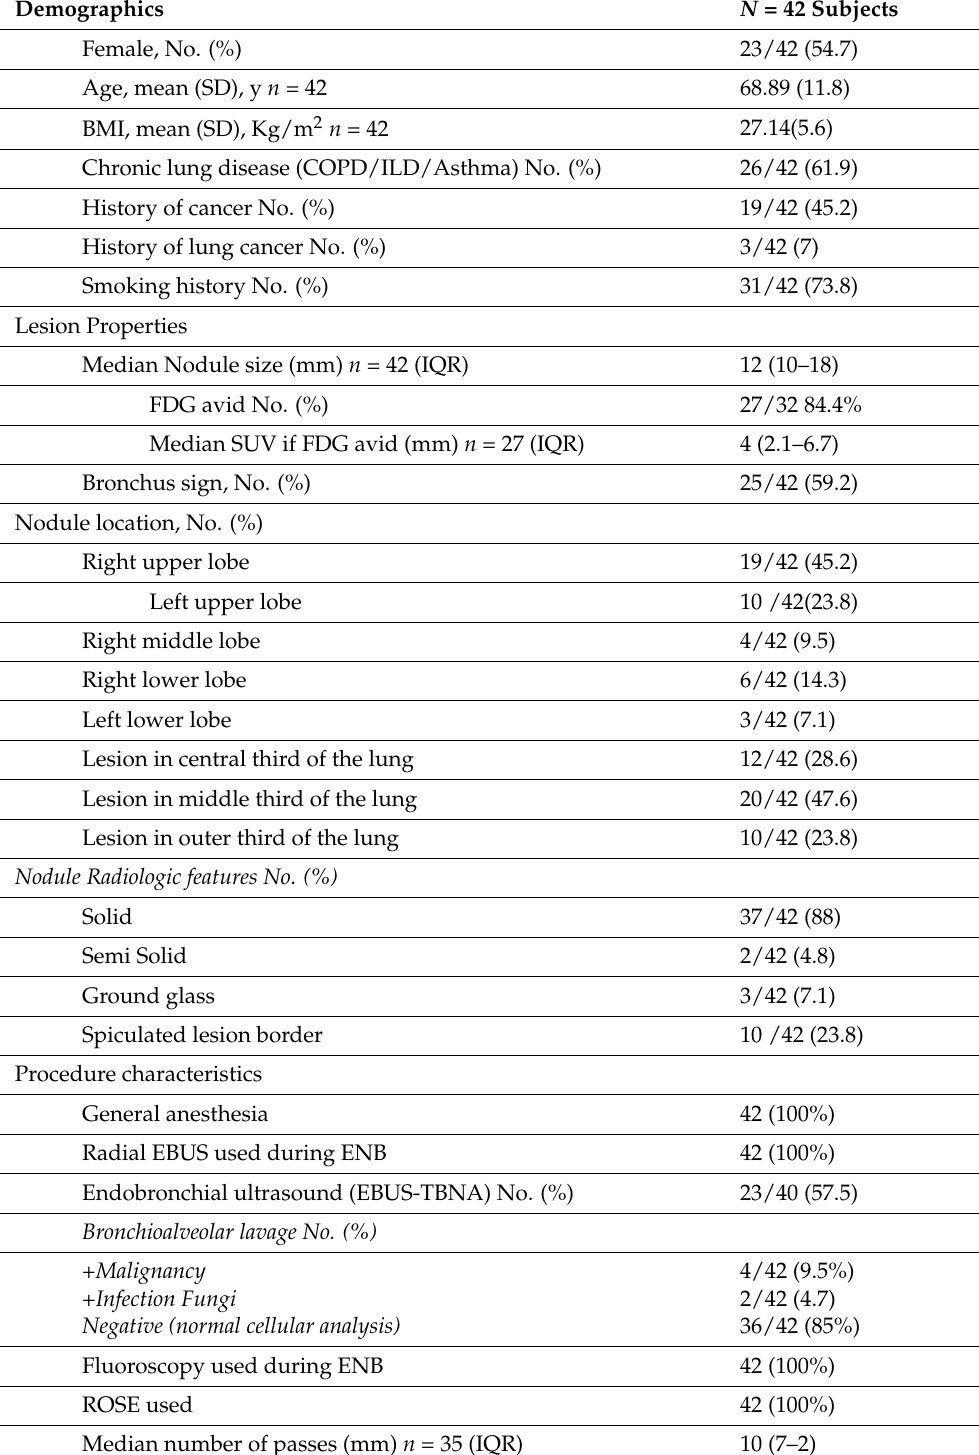
Table 1. Demographics, lesion, and procedural